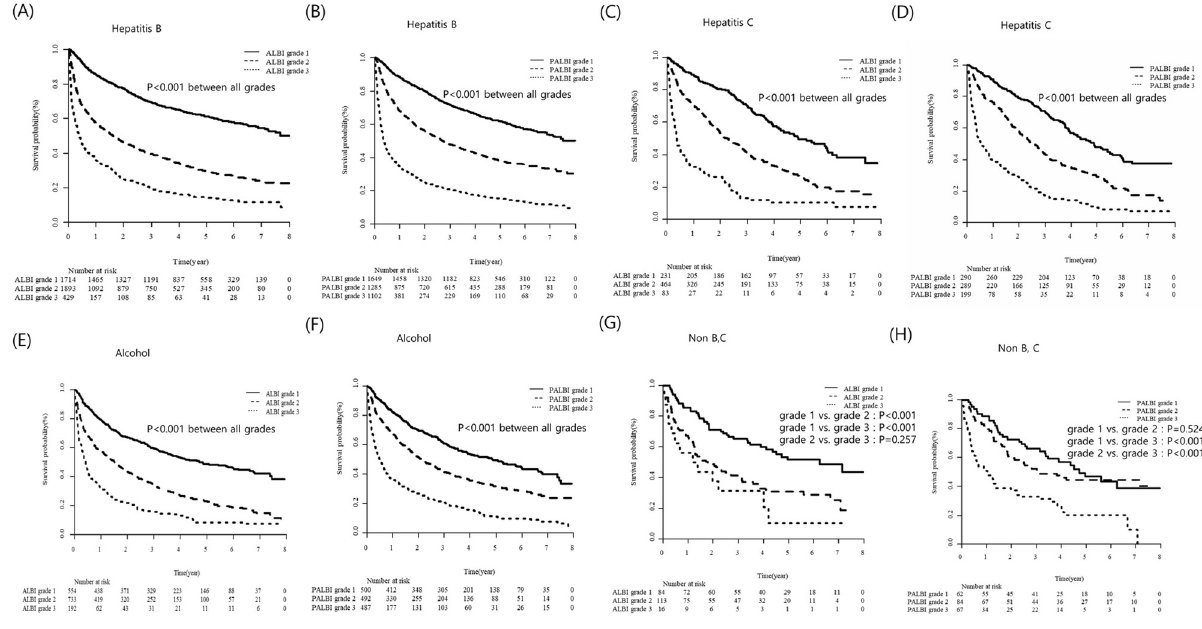
Fig 4. Utility of ALBI and PALBI grades according to different